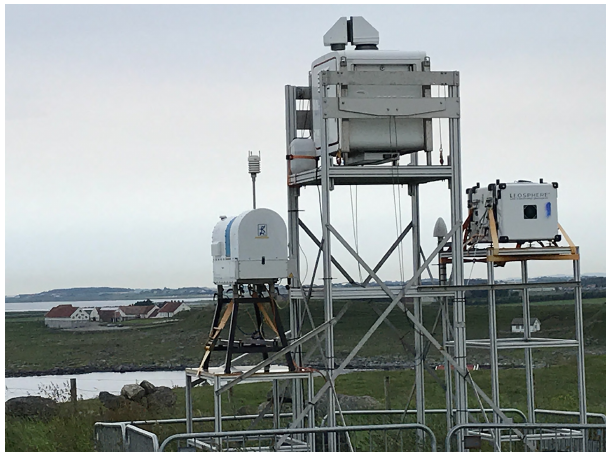
Figure 4. The main instrumental site of the COTUR campaign with one of the scanning lidars, Leosphere WindCube 100S (LidarN) in the centre, the Leosphere WindCube V1 wind profiler to the right, and the Radiometer Physics HATPRO RG4 passive microwave tem- perature and humidity profiler to the left. The picture was taken to- wards